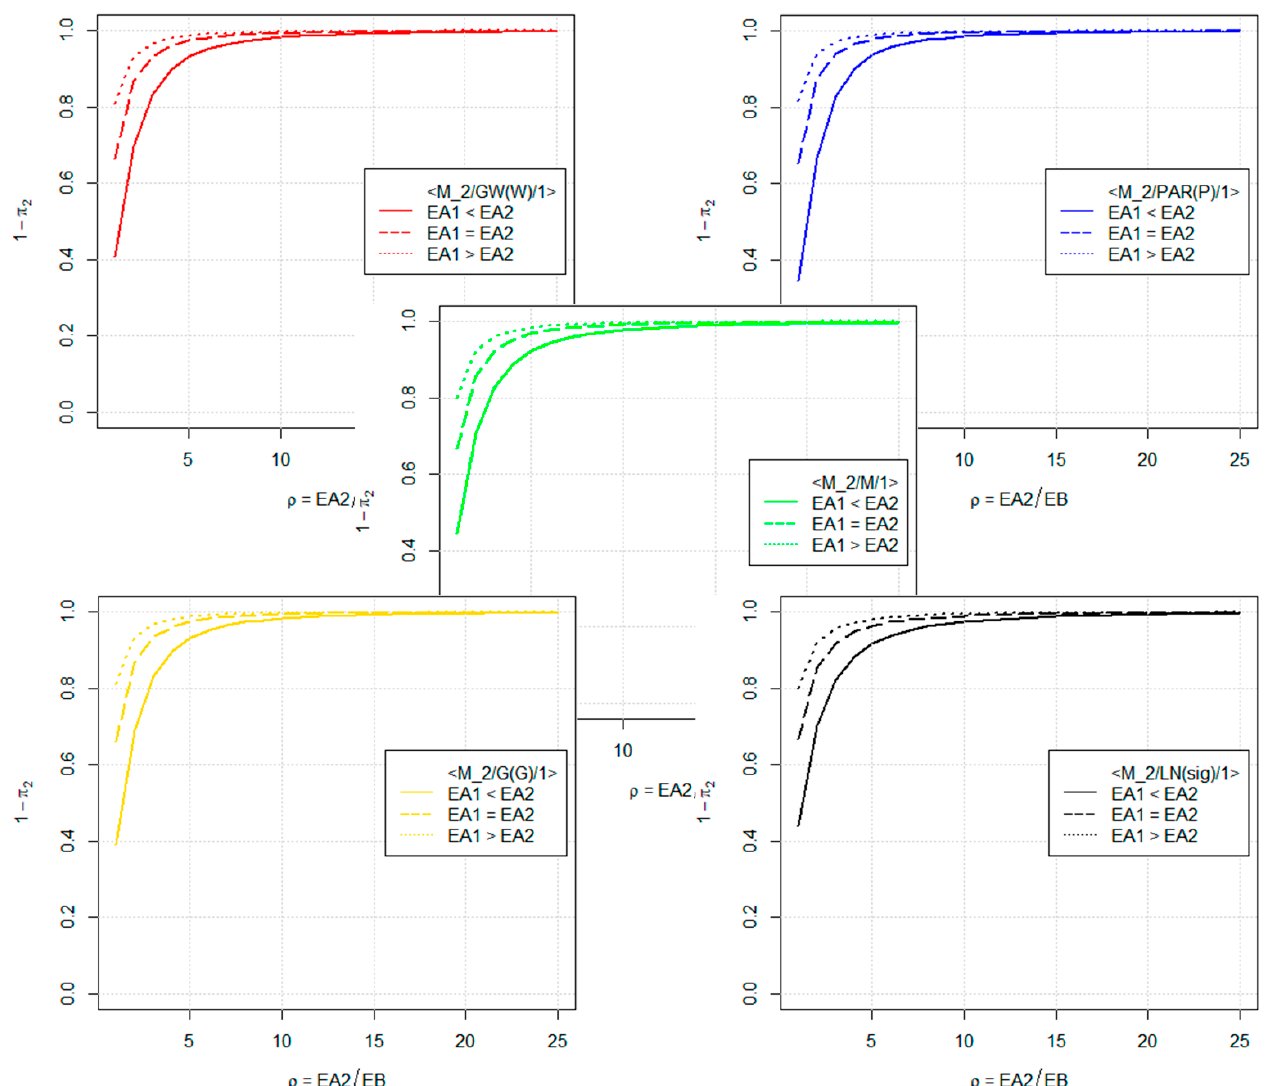
Figure 4. Graphs of the probability of failure-free system operation 1 − p 2 versus ρ